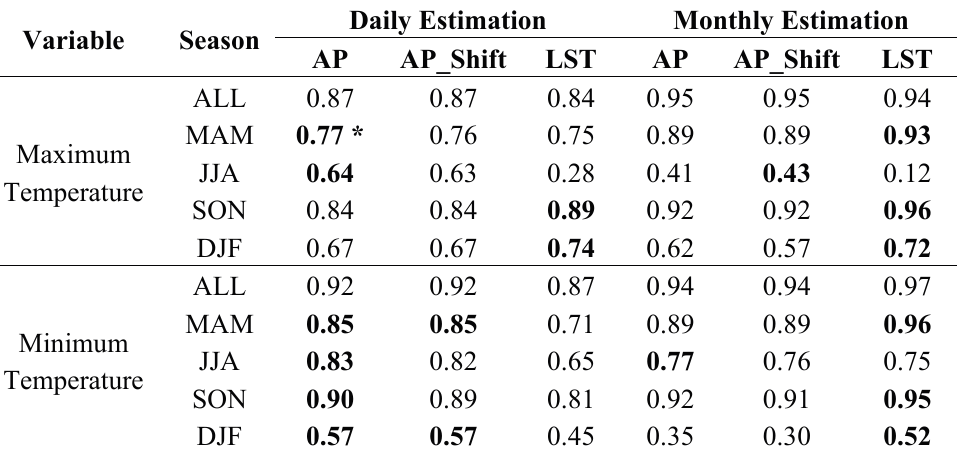
Table 1. Coefficient of determination (R 2 ) values averaged for 60 Automatic Synoptic Observation System (ASOS) weather stations’ locations for estimating daily and monthly air temperature